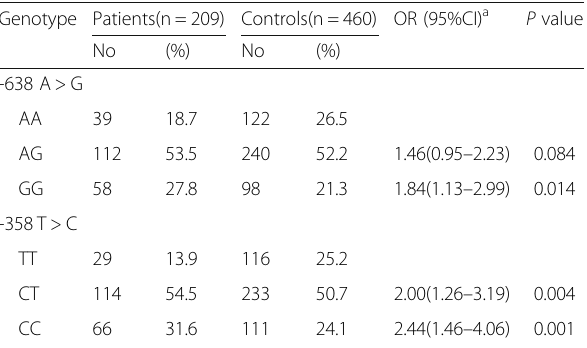
Table 4 Association of TNFSF15 – 638A > G polymorphism with SCLC risk stratified by selected variables